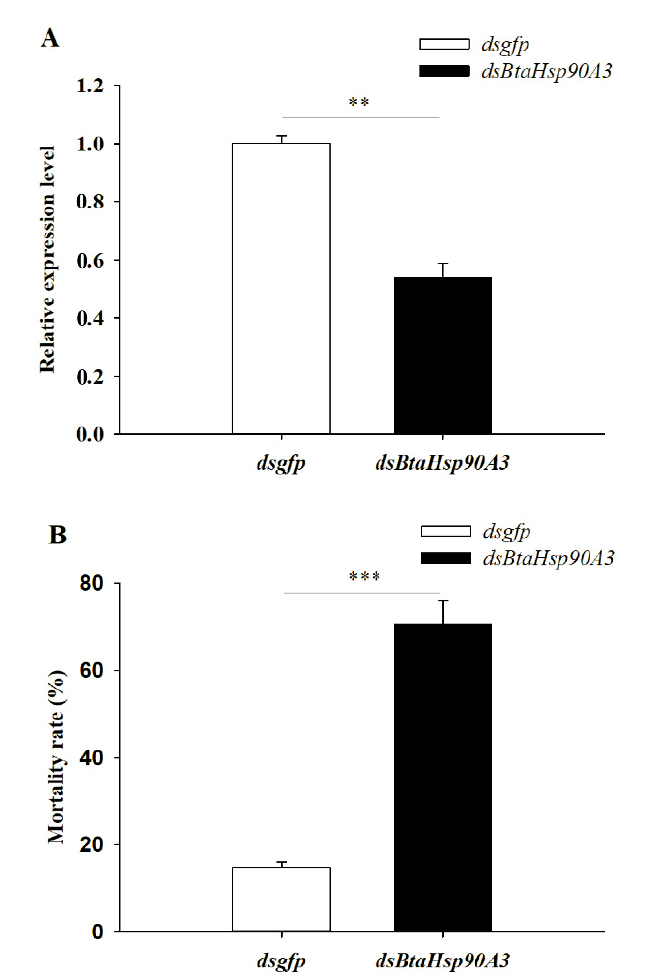
Figure 8. ( A ) RNAi efficiency of BtaHsp90A3 after feeding double-stranded RNA (dsRNA). ( B ) Survival rates: percentage of surviving adults after 42 °C treatment for 2 h. The survival rate of Bemisia tabaci treated with dsgfp and dsBtaHsp90A3 in different treatment groups. Significant differences are calculated by Student’s t -test, ** p < 0.01, *** p < 0.001.